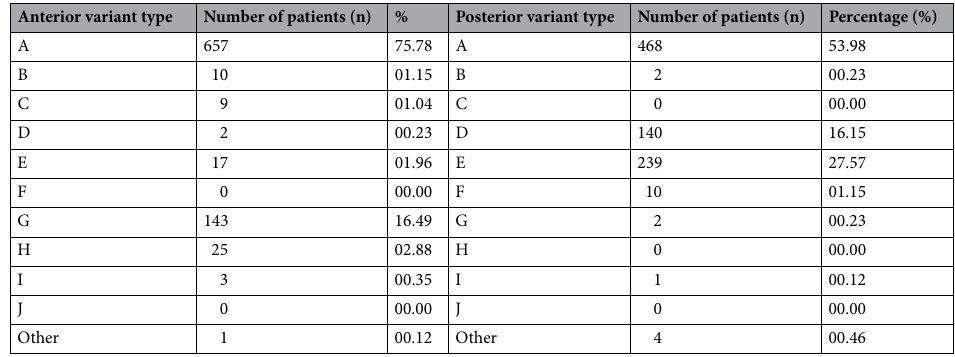
Table 2. Prevalence of anterior and posterior COW * variants. *Circle of